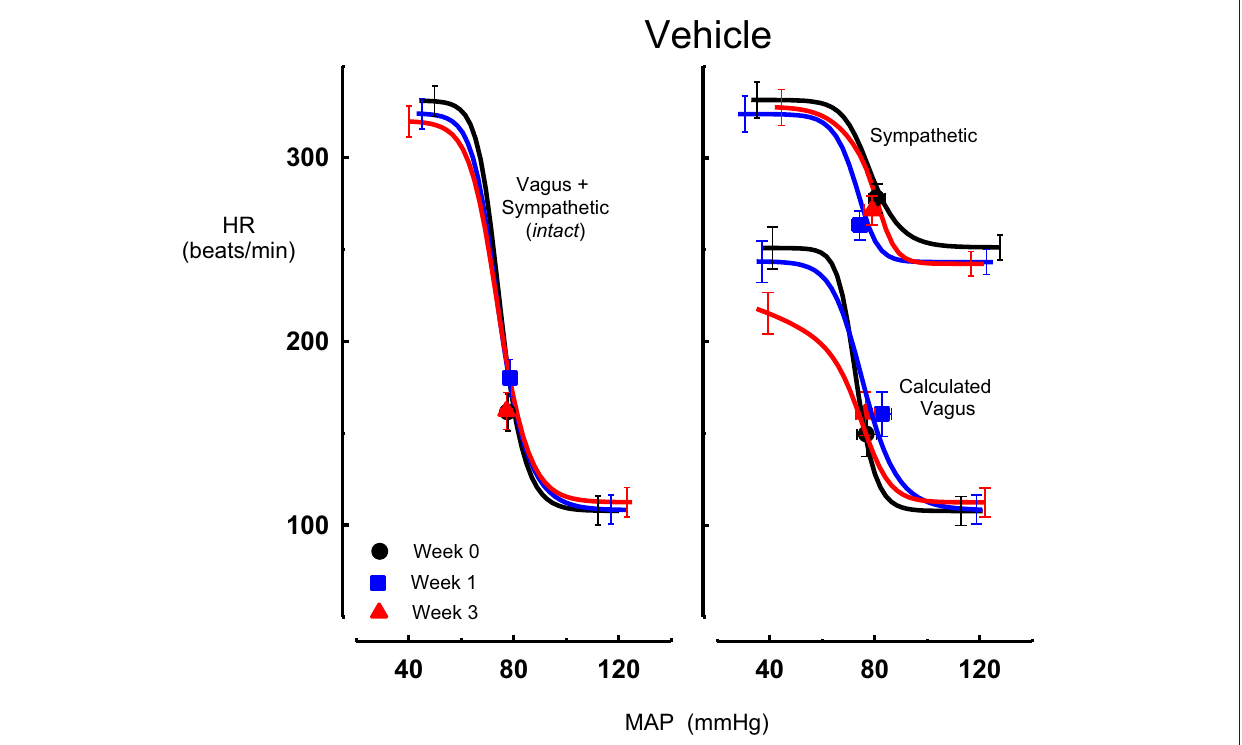
FIGURE 4 | Average sigmoid curves indicating the relationship between mean arterial pressure (MAP, mmHg) and heart rate (HR, beats/min) for the intact baroreflex curves (left panel) and the sympathetic and calculated vagal baroreflex curves (right panel) in seven conscious rabbits before (weeks 0, black line, black circles on all panels) and at weeks 1 (blue line, blue square on all panels) and 3 (red line, red triangle on all panels) of vehicle treatment. Symbols on curves represent resting values Error bars are average SEM indicating variation between animals calculated from the ANOVA.